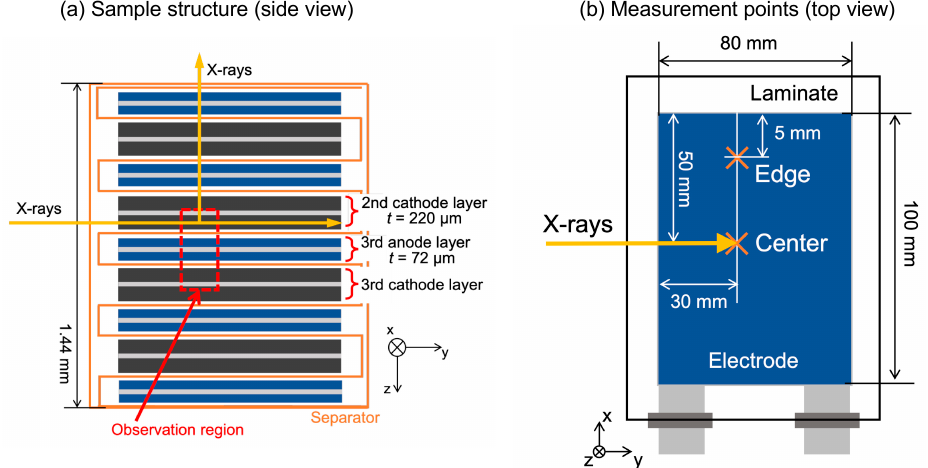
Figure 1. ( a ) Side view of stacked structure of laminated capacitor cell. Compton scattering X − ray energy spectra are measured within the dashed region using scanning incident X − rays; ( b ) top view of the electrode in the cell. Compton scattering measurements are performed on two positions marked by orange crosses.